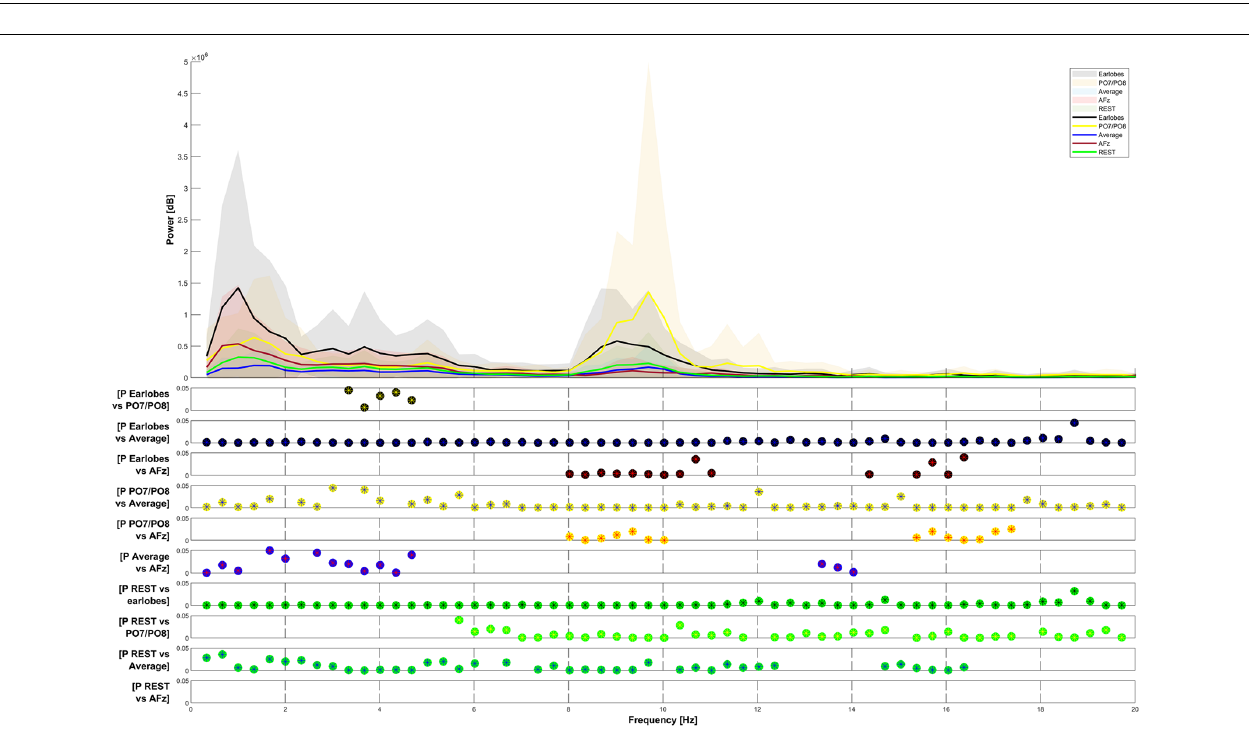
FIGURE 3 | CHEPS graphs for four reference sites. The results of the Friedman test were plotted as gray areas in the second half of the figure. Post hoc tests with a significance level p < 0.05 have been plotted for every reference site comparison.